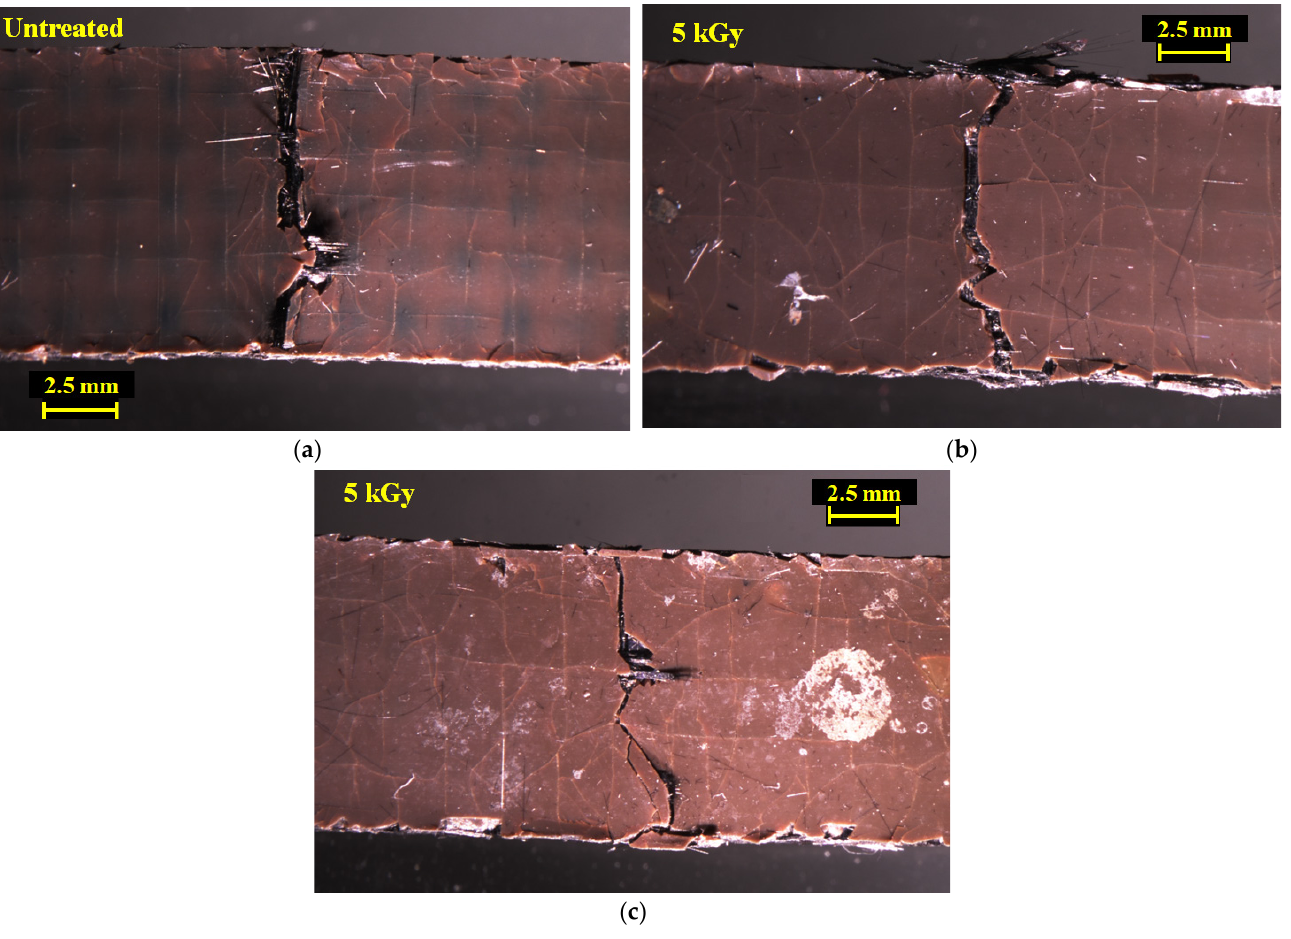
Figure 9. Optical microscope photos of tensile sides of untreated ( a ) and 5 kGy [PPS] 4[ CF] 3 samples ( b,c ) , respectively.